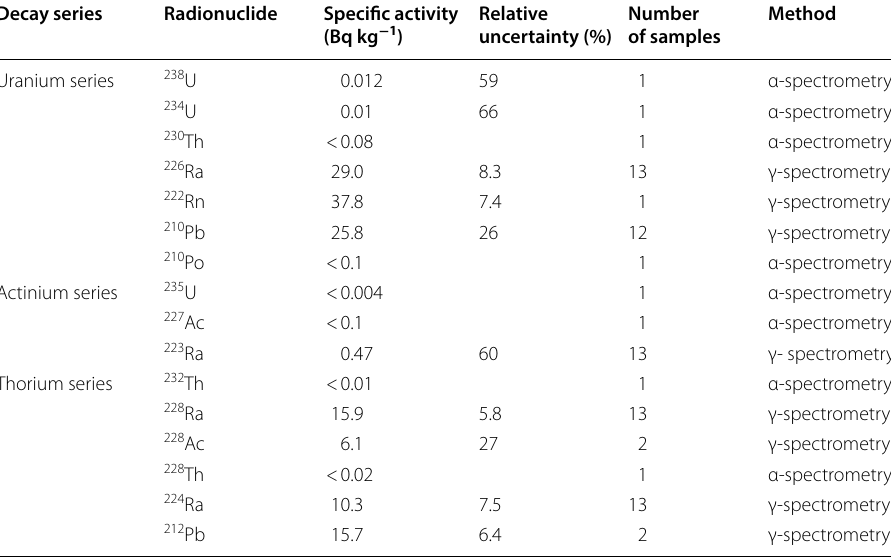
Relative uncertainties are quoted in percentage (